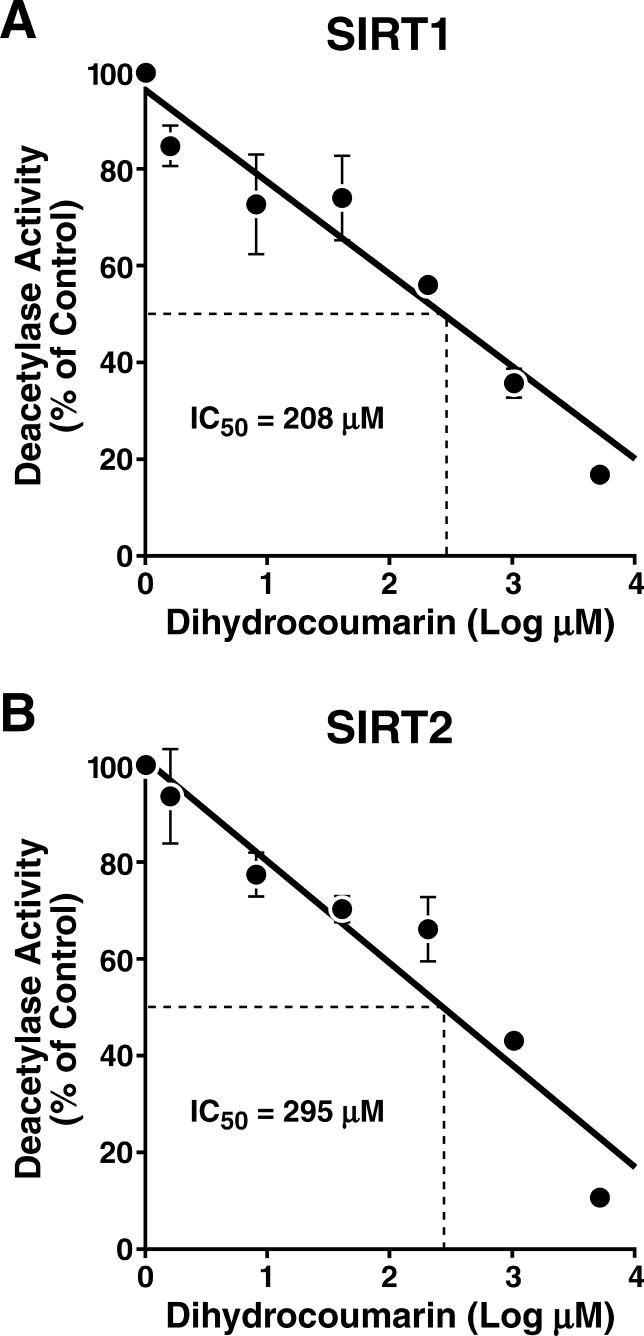
DHC Inhibits Human NAD+-Dependent Deacetylases In Vitro(A) Dose-dependent inhibition of SIRT1 (y = −19.98x + 96.431).(B) Dose-dependent inhibition of SIRT2 (y = −20.79x + 101.34). Averages ± standard error from two separate experiments are shown.